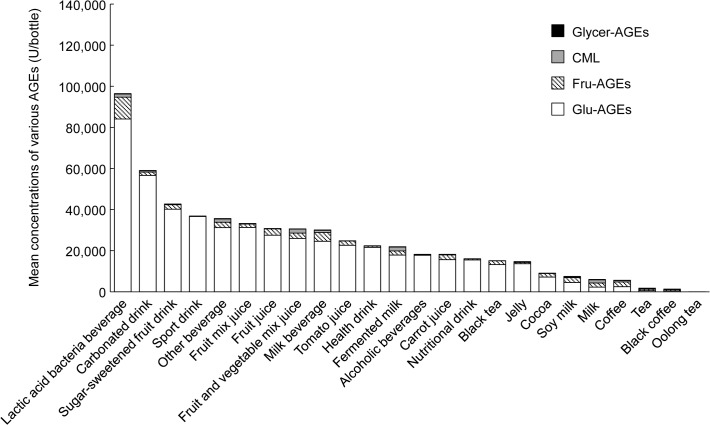
Mean concentrations of various AGEs in commonly consumed beverages.Beverages were classified according to the Japanese Agricultural Standard (JAS). The mean concentrations of four kinds of AGEs (Glu-AGEs, Fru-AGEs, CML, and Glycer-AGEs) in each beverage are expressed as AGE units (U) per bottle and are based on the standard serving size (65~500 ml/bottle) of each product in Japan.